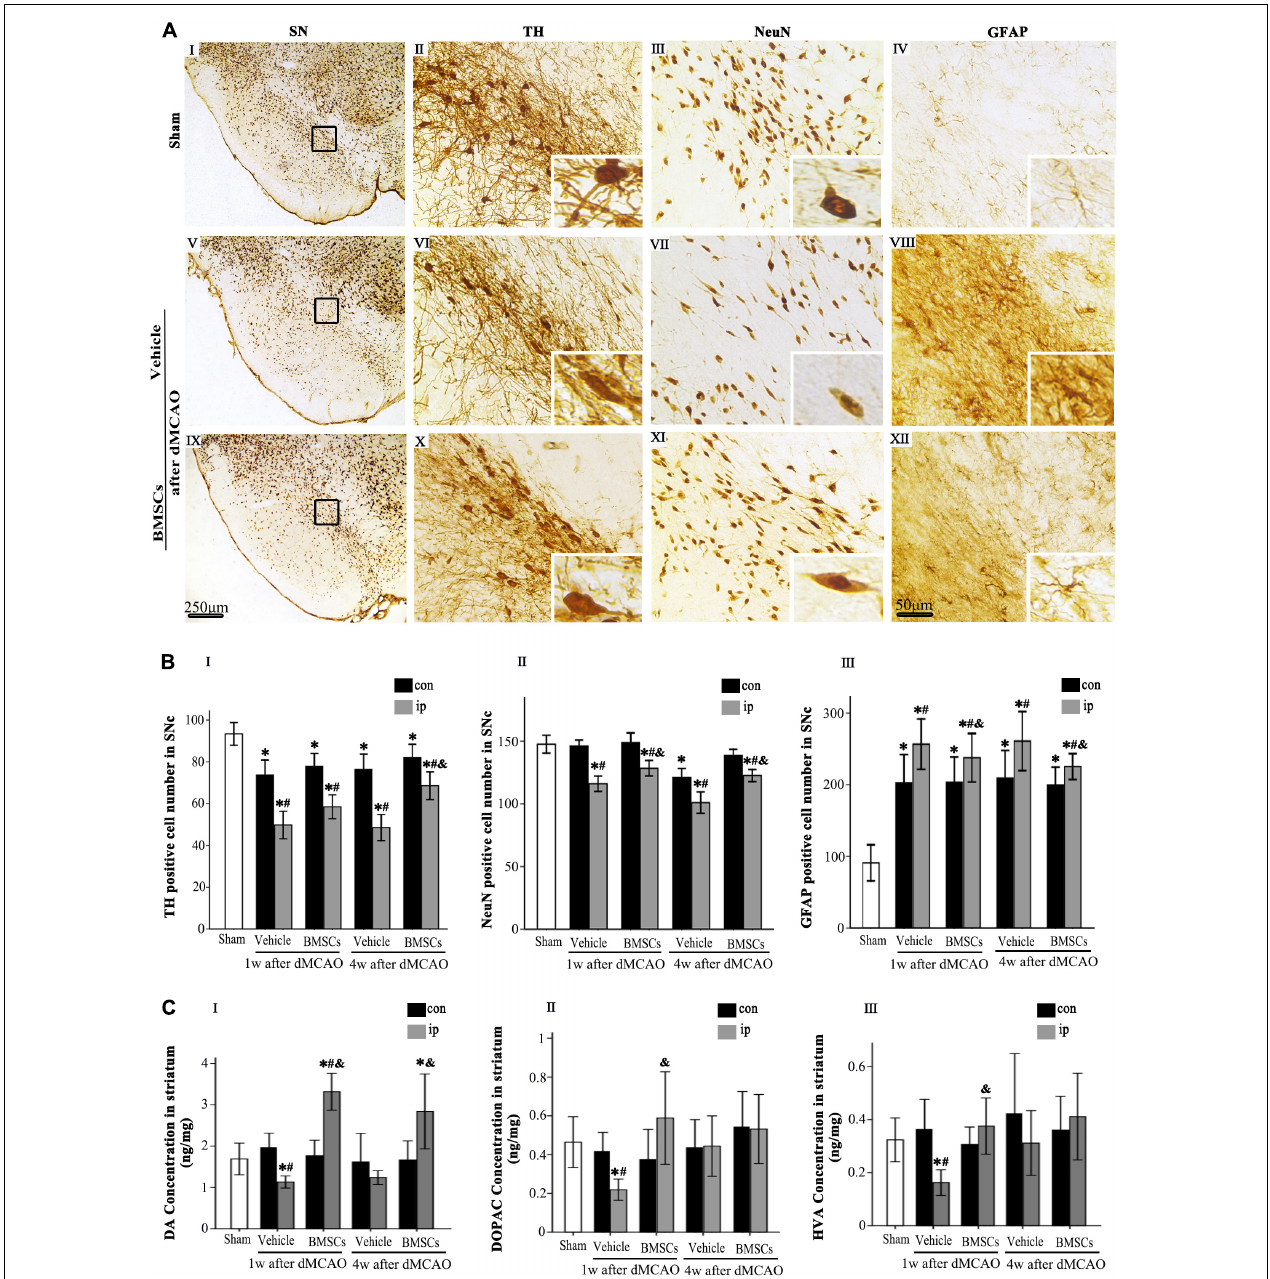
FIGURE 5 | Effects of BMSCs treatment on the number of TH, NeuN, and GFAP positive cells in SN, and DA and its metabolites in striatum at 4 weeks after dMCAO. (A) Representative microphotographs of immunohistochemistry for TH (II,VI,X) , NeuN (III,VII,XI) , and GFAP (IV,VIII,XII) in SN. The pictures on the right are magnified from the square area on the left. Scale bar: I, V, IX, 250 µ m; II–IV, VI–VIII, X–XII, 50 µ m. (B) Quantitative analyses of TH, NeuN, GFAP-positive cells in the SNc at 1 and 4 weeks after dMCAO. Transplantation of BMSCs increased the numbers of TH + [ F ( 2 , 60 ) = 31.51, p < 0.01] and NeuN + cells [ F ( 2 , 78 ) = 17.20, p < 0.01], and decreased the number of GFAP + cells [ F ( 2 , 78 ) = 1848.10, p < 0.01] in the ipsilateral SNc after dMCAO. Each bar represents the mean ± S.D. ∗ p < 0.05 vs. sham-operated group, # p < 0.05 vs. contralateral groups at the same time point and & p < 0.05 vs. ipsilateral vehicle groups ( n = 6 in each group). (C) The DA (I) , DOPAC (II) , and HVA (III) concentrations in striata at 1 and 4 weeks after dMCAO with or without BMSCs transplantation. Transplantation with BMSCs increased the concentration of DA [ F ( 2 , 8 ) = 6.33, p < 0.05] in the ipsilateral striatum after dMCAO, maintained the concentration of DOPAC [ F ( 2 , 11 ) = 0.53, p > 0.05] and HVA [ F ( 2 , 11 ) = 0.67, p > 0.05] in the ipsilateral striatum after dMCAO. Each bar represents the mean ± SD ∗ p < 0.05 vs. sham-operated group and # p < 0.05 vs. contralateral groups at the same time point and & p < 0.05 vs. ipsilateral vehicle groups ( n = 4 in each group). SN, substantia nigra; SNc, substantia nigra compact part; TH, tyrosine hydroxylase; NeuN, neuron-specific nuclear-binding protein; GFAP, Glial fibrillary acidic protein; Sham, sham-operated; BMSCs, bone marrow stromal cells; DA, dopamine; DOPAC, 3,4-dihydroxyphenylacetic acid; HVA, homovanillic acid; con, contralateral; ip, ipsilateral; w, week; dMCAO, distal middle cerebral artery